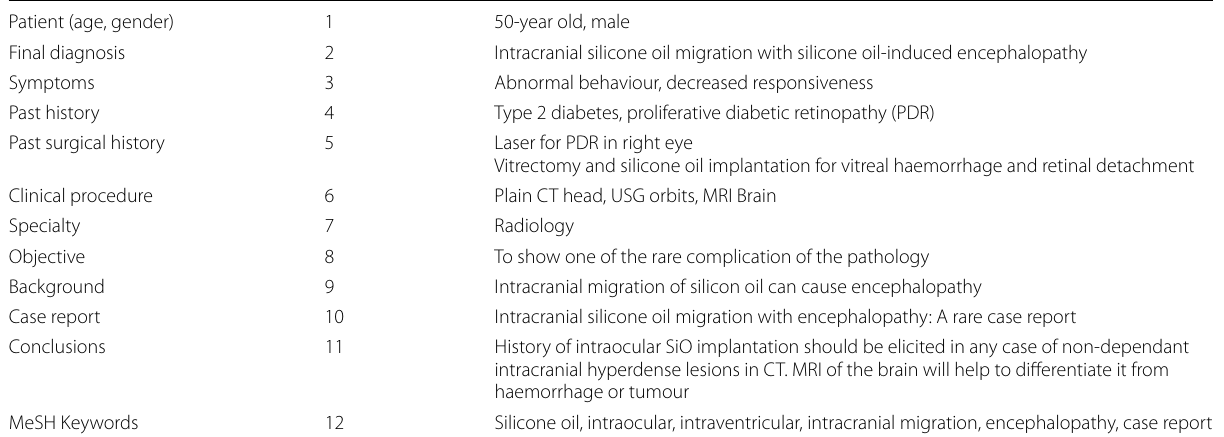
Table 1 Summary of the